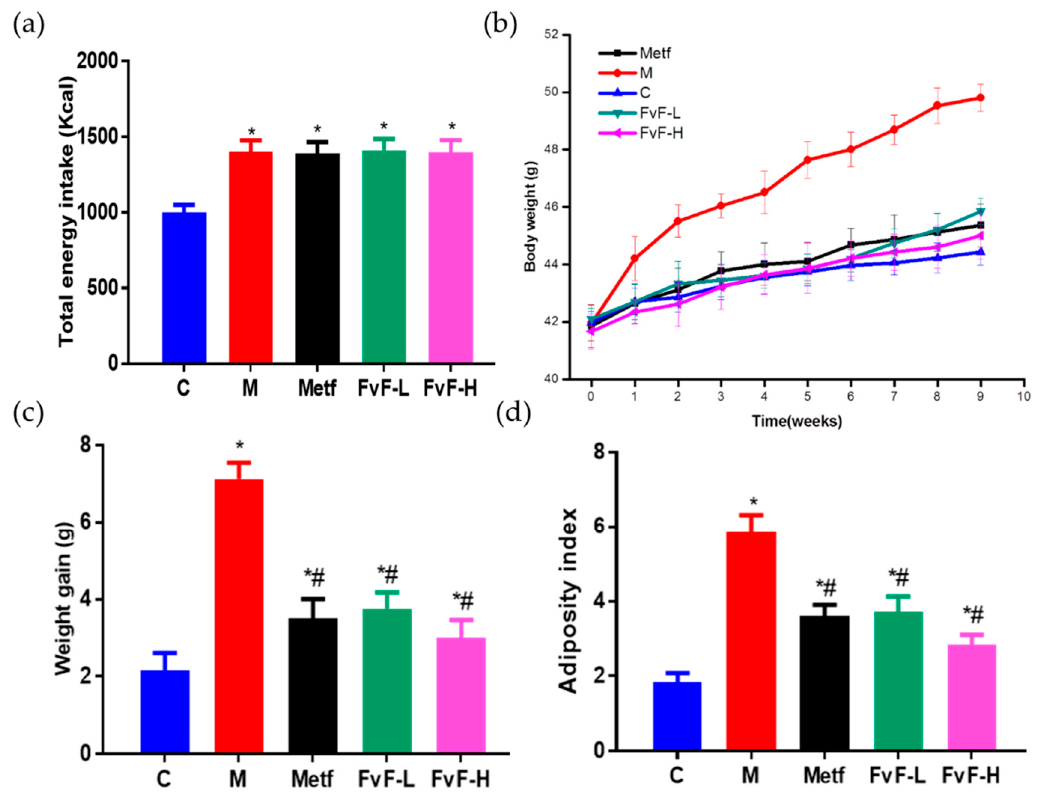
Figure 4. Effects of fucoidan from Fucus vesiculosus (FvF) on total energy intake, body weight gain, and adiposity index in high-fat diet (HFD) and streptozotocin (STZ)-induced metabolic syndrome (MetS) mice. ( a ) Total energy intake; Body weight ( b ) and weight gain ( c ) during 9 weeks feeding trail; ( d ) Adiposity index, calculated according to the formula: 100 × (perirenal fat pad + epididymal fat pad)/body weight. C, mice were fed a normal diet; M, mice were fed a HFD; Metf, mice were fed a HFD with 225 mg/kg/day metformin; FvF-L, mice were fed a HFD with 20 mg/kg/day FvF; FvF-H, mice were fed a HFD with 100 mg/kg/day FvF. Data are expressed as the mean ± SEM. Differences were assessed by ANOVAs and statistical results are denoted as follows: * p < 0.05 versus the control group; # p < 0.05 versus the model group.